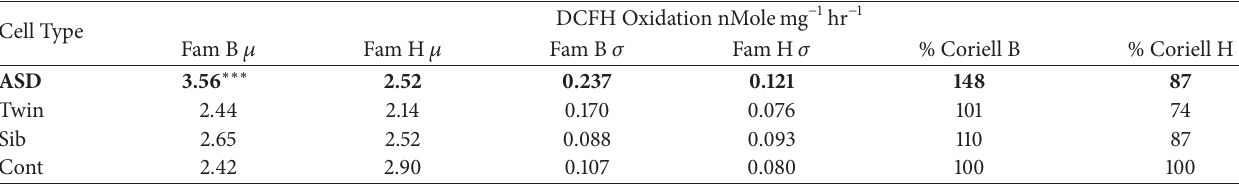
Table 1: The rate of DCFH oxidation for cells drawn from Families B and H. Twelve independent measurements were taken for each family and averaged to yield the means ( 𝜇 ) and standard deviations ( 𝜎 ) shown. The ASD cell type was the only cell type that differed significantly between the two families ( 𝑃 = 0.000121).